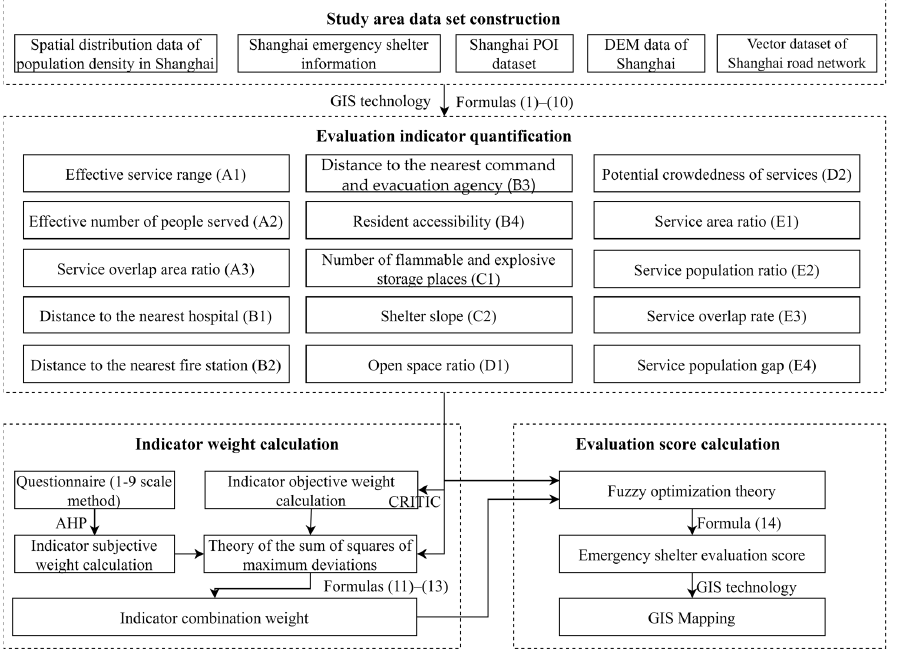
Figure 2. The control of indicators of effective shelter area per capita and service radius of